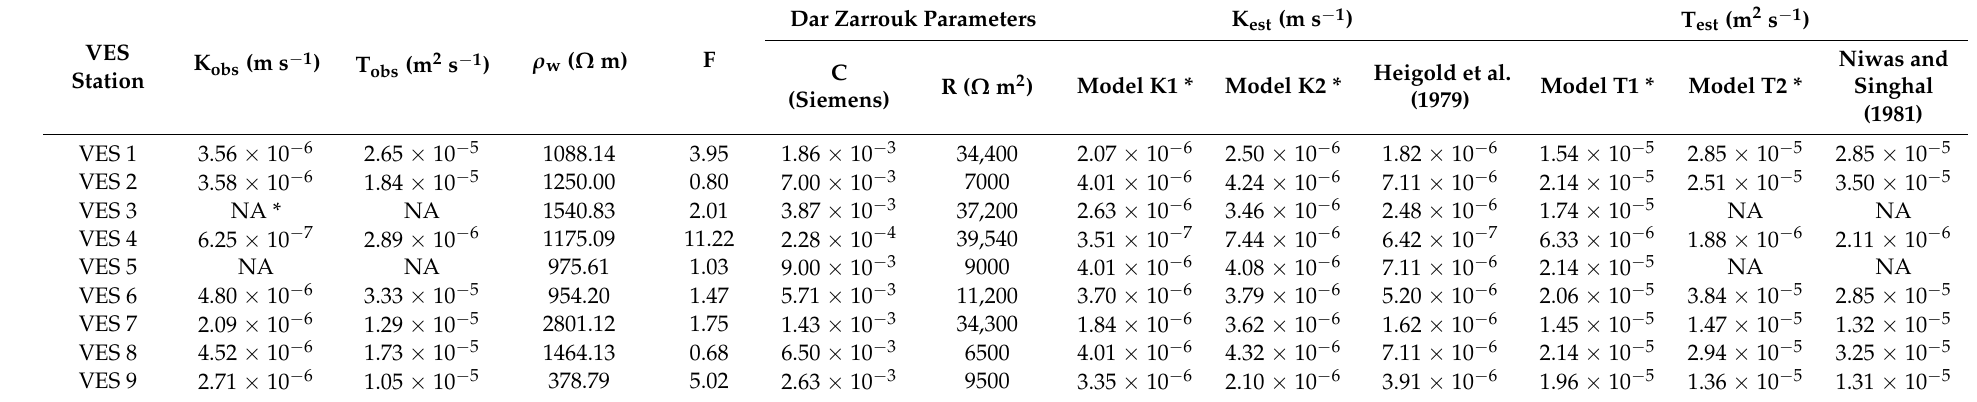
Table 2. Porous aquifer hydraulic parameters determined in field (slug test) and estimated from the geoelectric parameters. Relationships presented by Heigold et al. (1979) [24] and Niwas and Singhal (1981) [8] allowed the evaluation of estimates using empirical relationships proposed in this